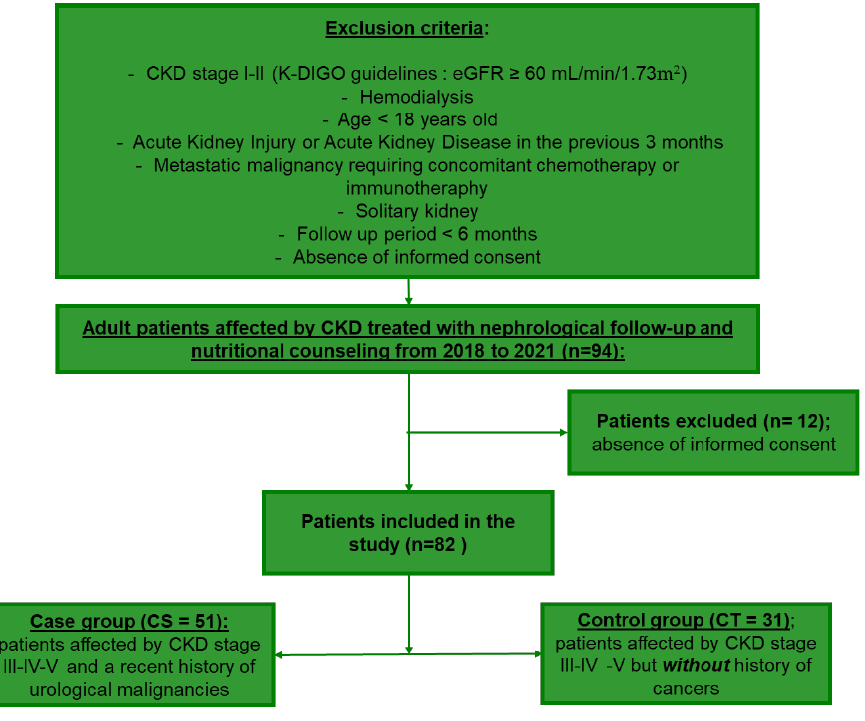
Figure 1. Flow chart for cohort assembly.